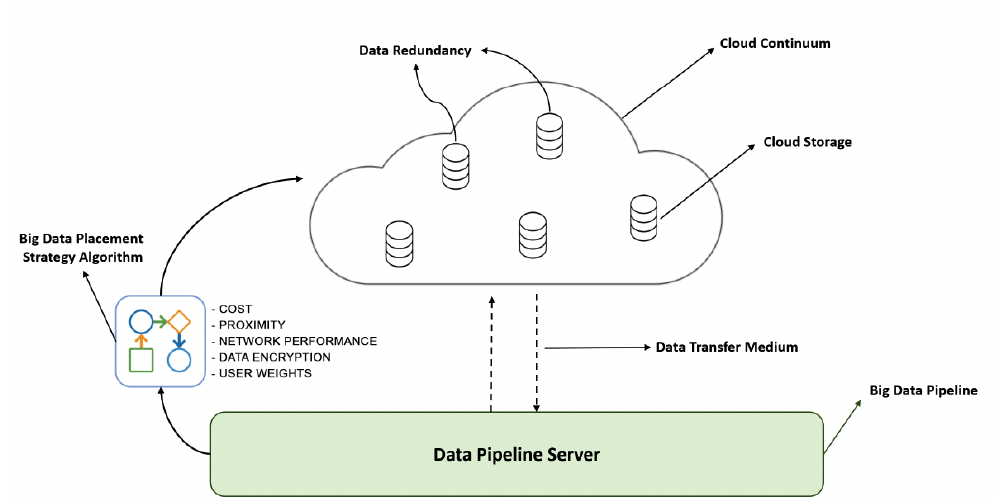
Figure 1. Big data pipelines with StaaS and smart data